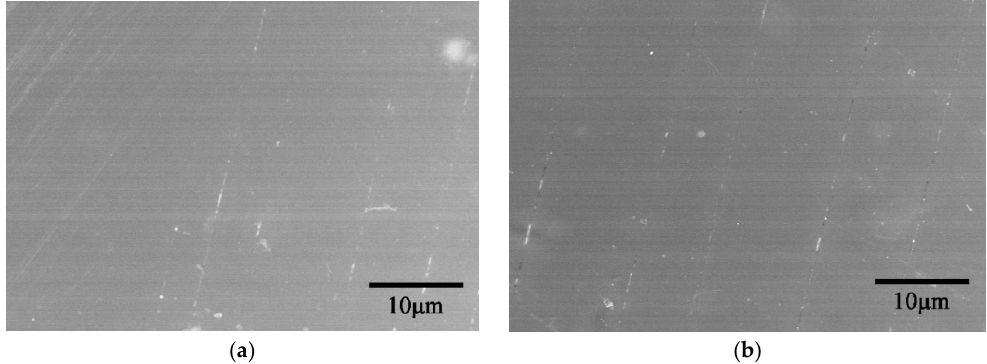
Figure 7. SEM image of Kapton/Al 2 O 3 surface nanocomposite film before ( a ) and after ( b ) curling.